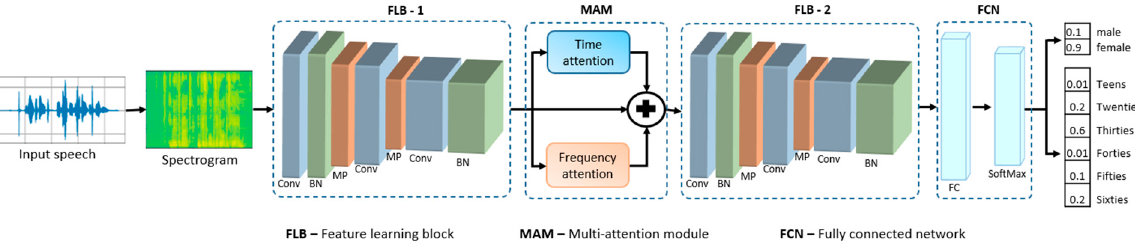
Figure 1. An overview of the proposed age and gender recognition framework. FLB-1—first FLB, which extracts local feature maps. MAM selects the unique characteristics of both time and frequency. FLB-2—second FLB that learns high-level salient feature maps. FCN extracts global features and performs classification. Conv—convolution layer, BN—batch normalization layer, MP—max-pooling layer, FC—fully connected layer.